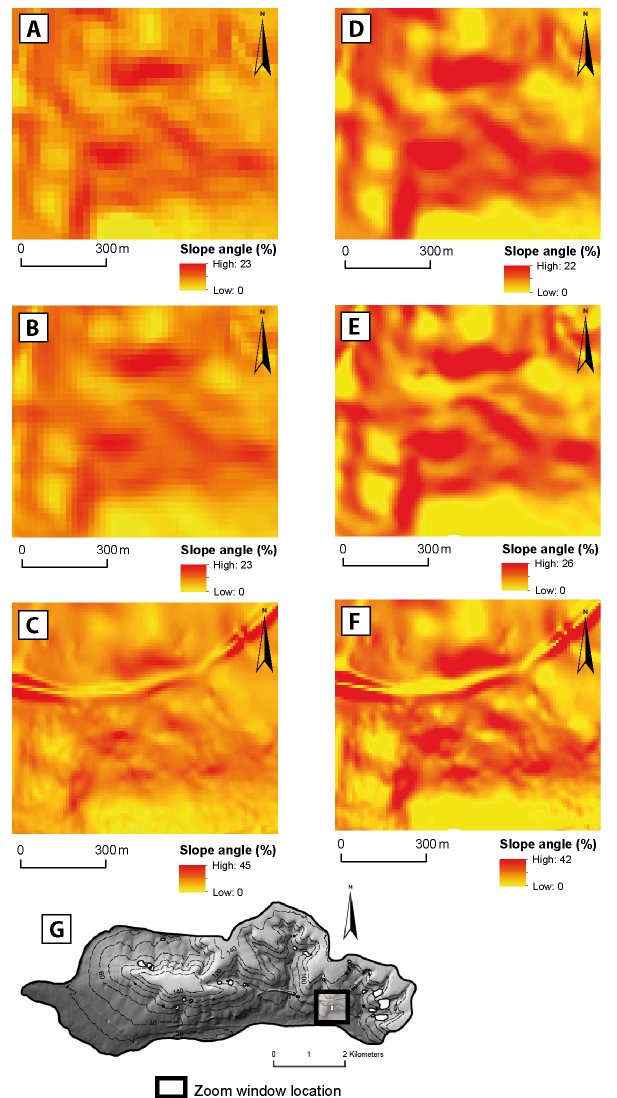
Fig. 7. Example of the three different slope maps generated from the available DEMs in their original cell size resolution and after bilin- ear resampling at 10m; detailed zoom on a representative area. (A) Raw BDAlti ® 25m, (B) raw contour lines DEM 15m, (C) raw radar DEM 5m, (D) resampled BDAlti ® slope map 10m, (E) resampled contour lines DEM slope map 10m, (F) resampled radar slope map 10m and (G) location of the illustrative zoom in the study area. (Note: road embankments are not visible on the two first DEMs.)